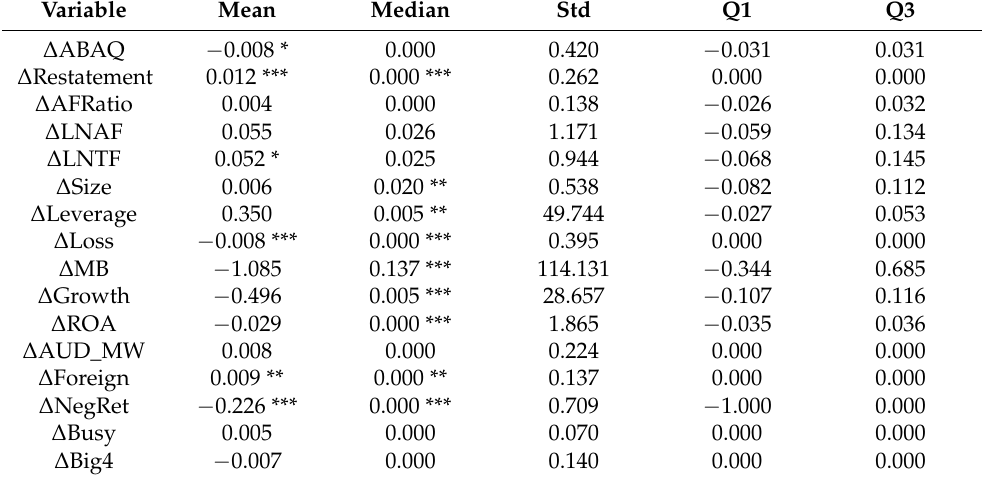
Table 2. Cont. Panel D: Descriptive Statistics for the ABAQ, Restatement, and AF of U.S. sample firms in 1-year post-Rule 3211 period, after 1st-differencing data.